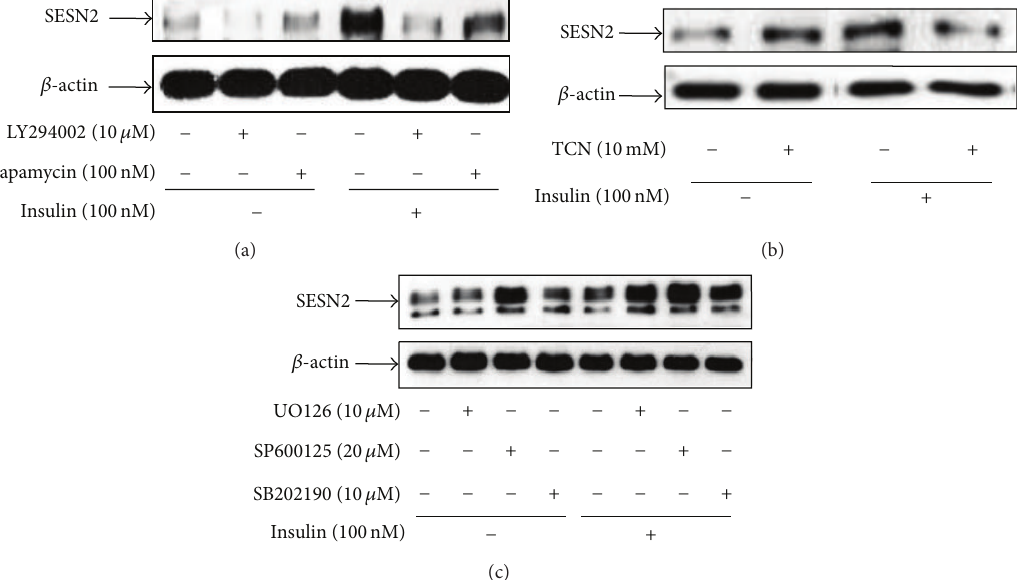
Figure 2: PI 3 K/mTOR signaling pathway is required for the upregulation of SESN2 level by insulin treatment. HepG2 cells were pretreated with indicated reagents at the indicated concentrations for 1h, followed by an 18 h further treatment with 100 nM of insulin. Cells were harvested for western blotting. (a) to (c) are representative images of at least three independent experiments. signaling transduction by PTEN-mediated PI 3 K downregu-